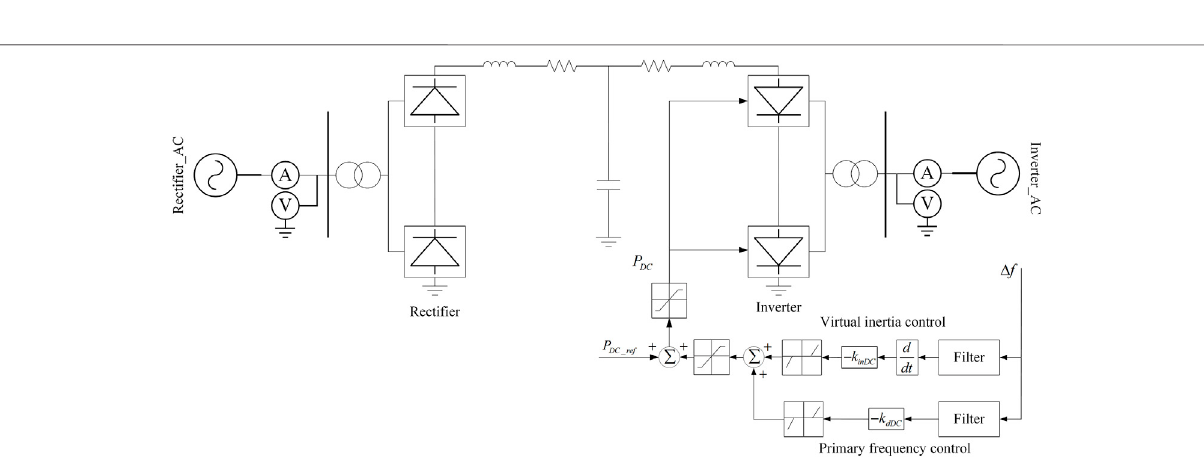
FIGURE 3 | Block diagram of the primary frequency control base on the droop controller of UHVDC.